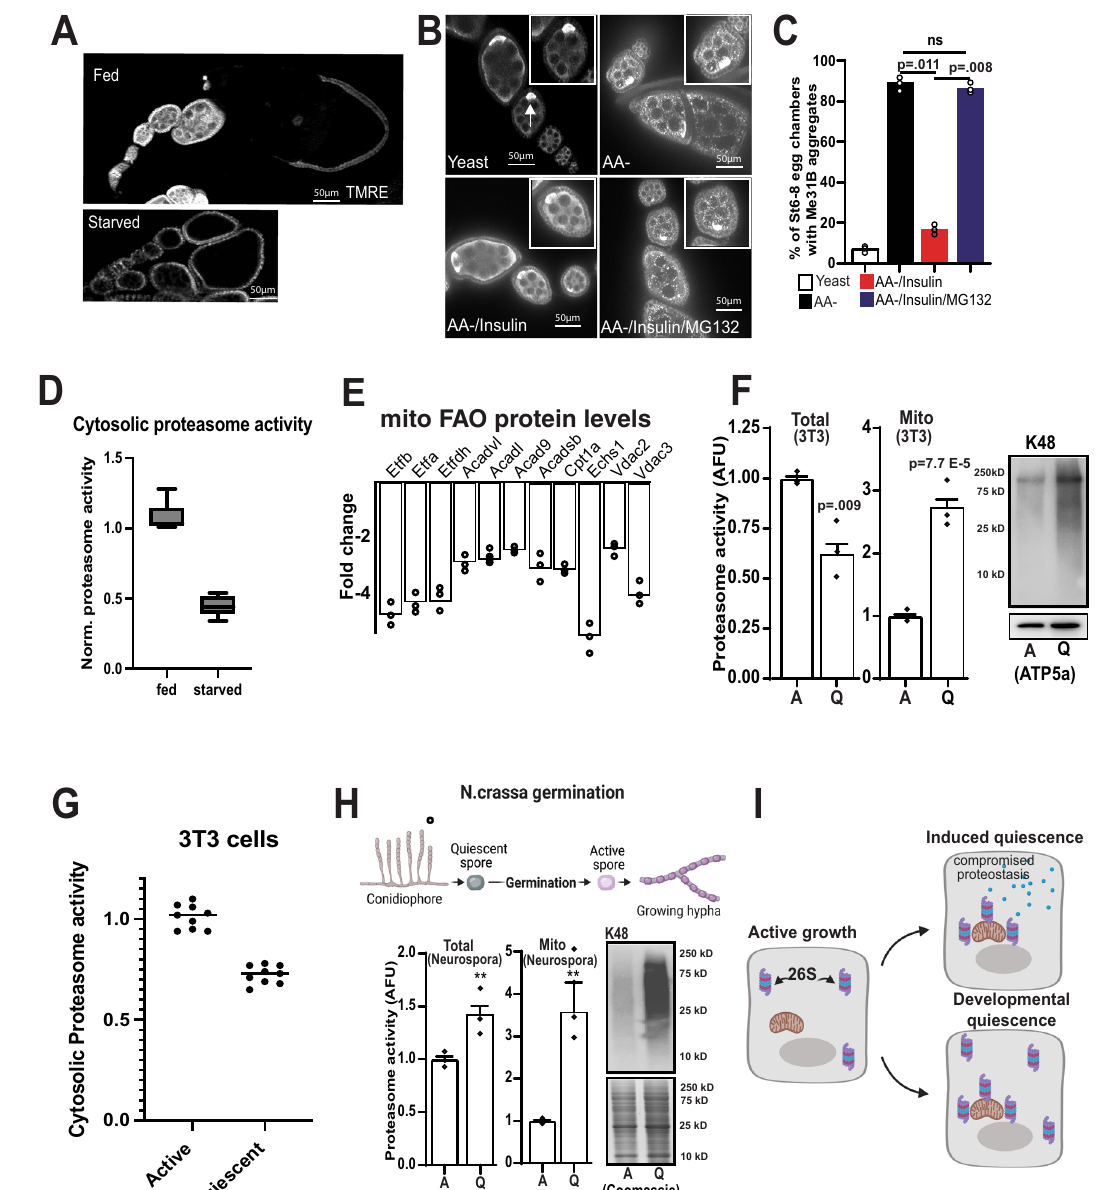
Fig. 5 | Proteasome recruitment to the mitochondria is highly conserved in developmentalandstarvation-inducedformsofquiescence.A TMREstainingof ovarioles from starved vs fed animals. B Immunostaining wild-type ovarioles to detect Me31B with indicated feeding and treatment strategies. C Summary of percentage of stage 6 – 8 egg chambers with Me31B aggregates in B ( n =25 egg chambers). P valueswerecalculatedbyone-wayanalysisofvariance(ANOVA).Error barsrepresentonestandarddeviation. D Cytosolicproteasome activityfromstage 1 – 8 egg chambers from fed and starved oocytes ( n =3 completely independent experiments on independent samples 6 total samples). E Fold changes of selected FAOpathwayenzymesandVDACsinquiescentNIH3T3cellscomparedwithactive ones ( n =3 independent replicates). F Total and mitochondria-associated protea- some activity and K48 ubiquitin levels in actively growing and quiescent NIH 3T3